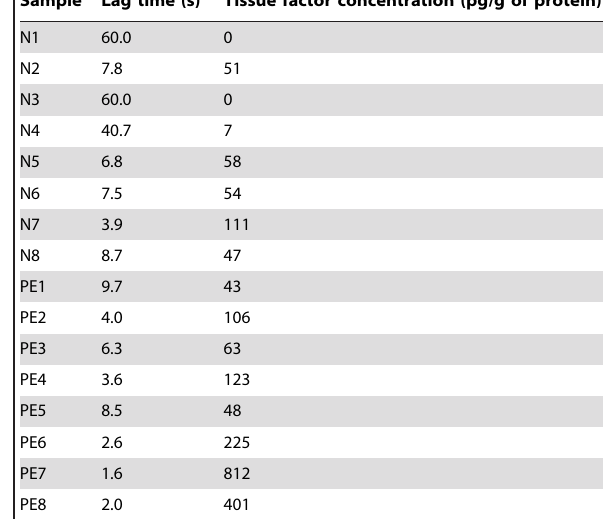
Table 2. Tissue factor content of syncytiotrophoblast